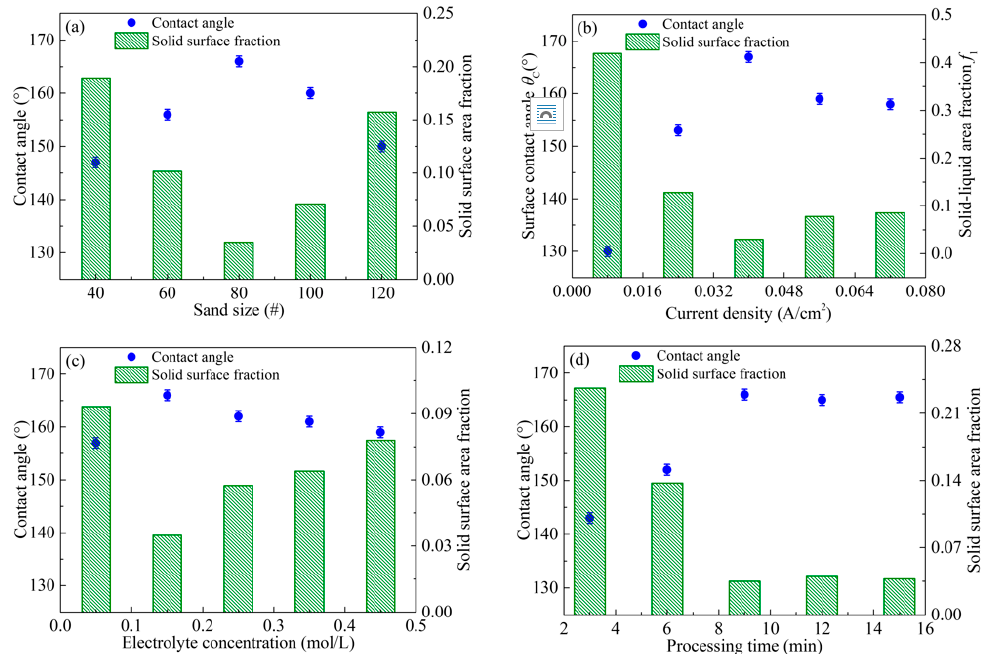
Figure 6. Influence of sand size ( a ), current density ( b ), electrolyte concentration ( c ) and processing time ( d ) on the contact angle and area fraction of the fabricated surface.